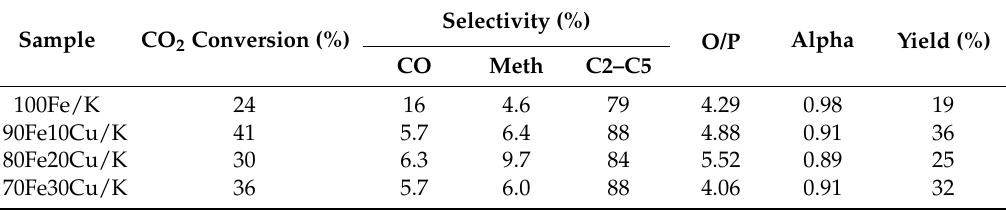
Table 1. Activities of FeCu/K catalysts with various Fe:Cu ratios.